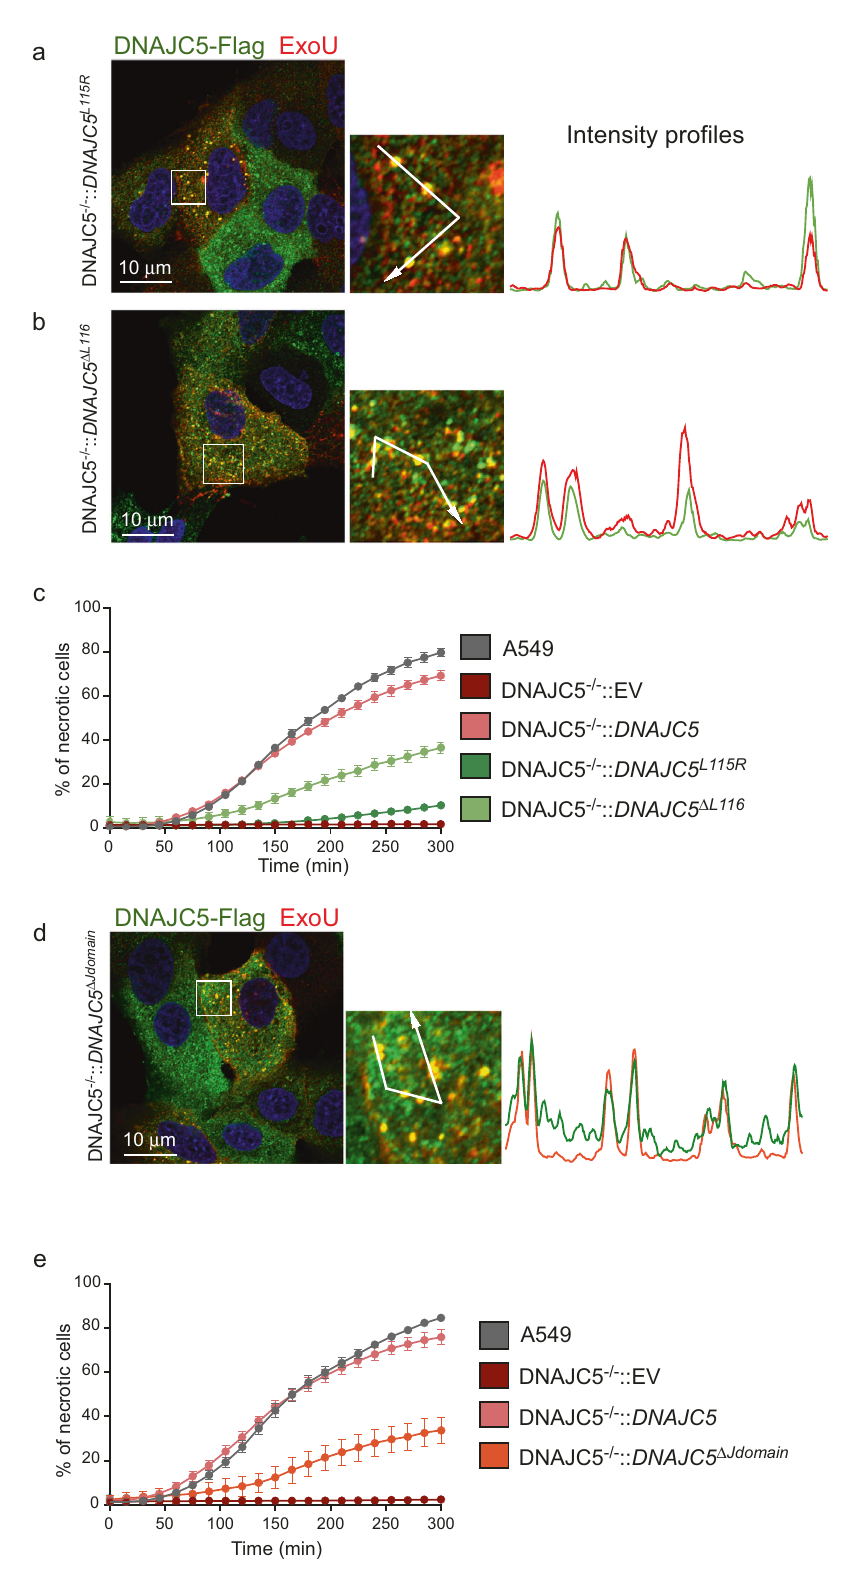
For exoU-bla fusion, the DNA fragment encompassing the exoU promotor and coding sequence was ampli fi ed by primers ExoU-BamHI and ExoU-XbaI (Supplementary Table 2) using pIA exoU S142A spcU as template 39 . The PCR fragment was then transferred into Bam HI- and Xba I-digested pIA exoS - bla plasmids, where exoS was excised. The expression and secretion of ExoU-Bla were veri fi ed by immuno-blotting using anti-ExoU antibodies. The plasmids were introduced into PP34 Δ exoU by transformation 64 . expressing lentiviruses were produced as described in Moffat ’ s lab